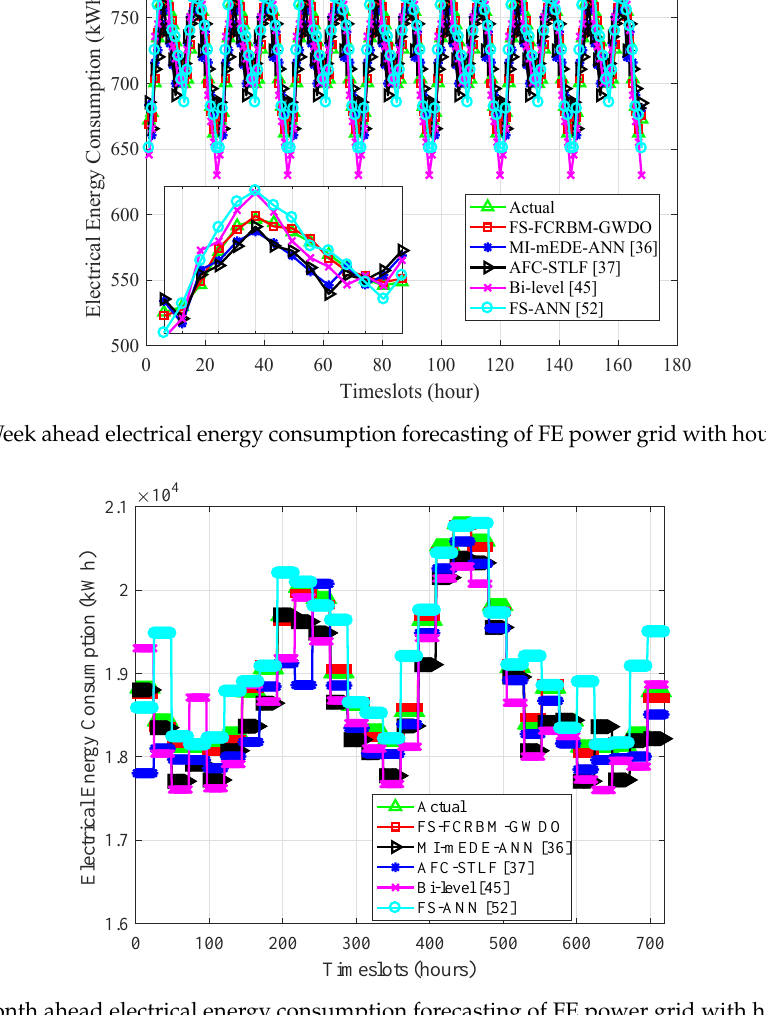
Figure 10. Month ahead electrical energy consumption forecasting of FE power grid with hour